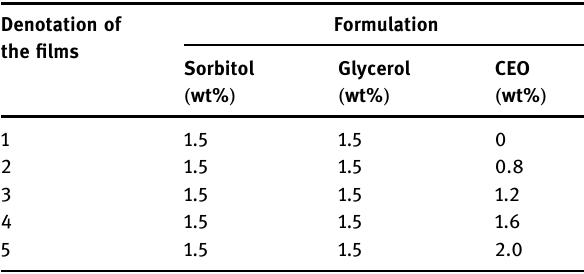
Table 1: Denotations of SPS/SPNCC - incorporated CEO nanocom - posite fi lms